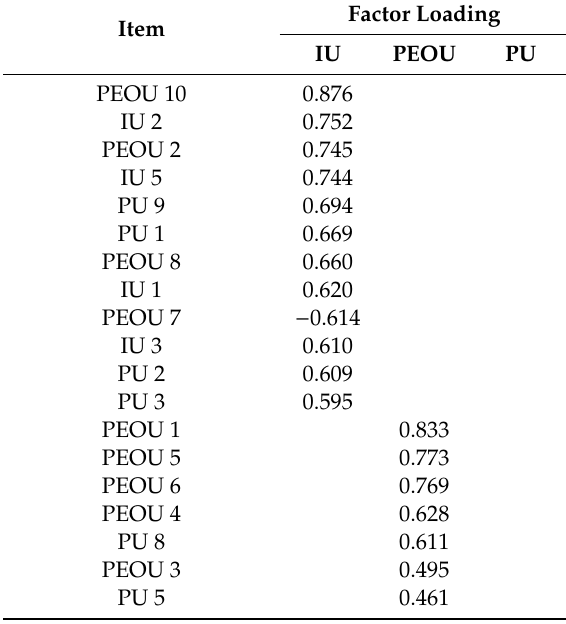
Table 2. Summary of principal component analysis results for the 15 questions (except for item